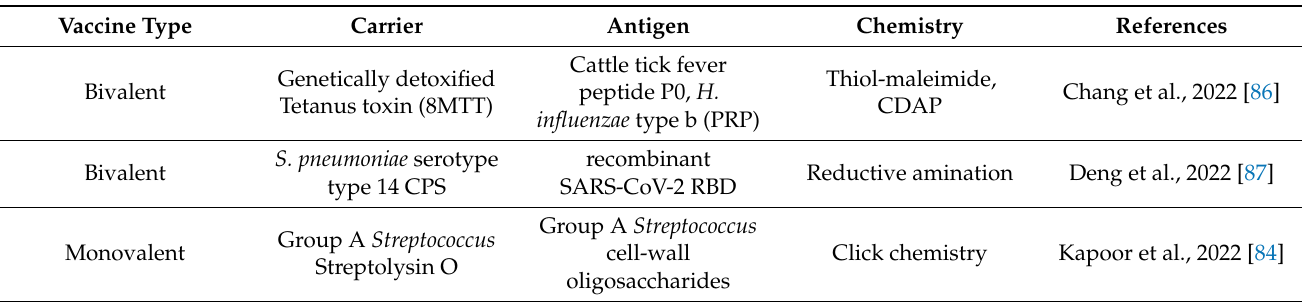
Table 3. Protein-based conjugation